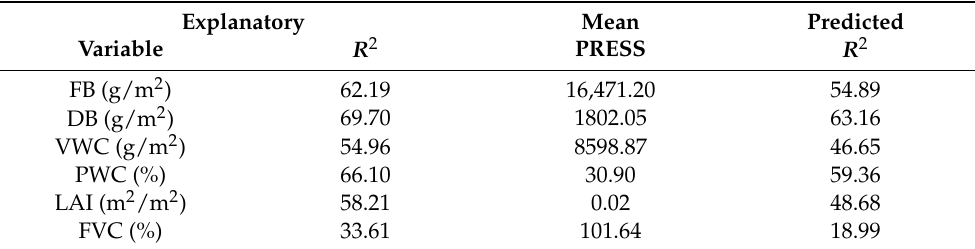
Table 8. Predictive capacity of the PLS analysis for each of the response variables of PBT, PT, PR and PO associations for four